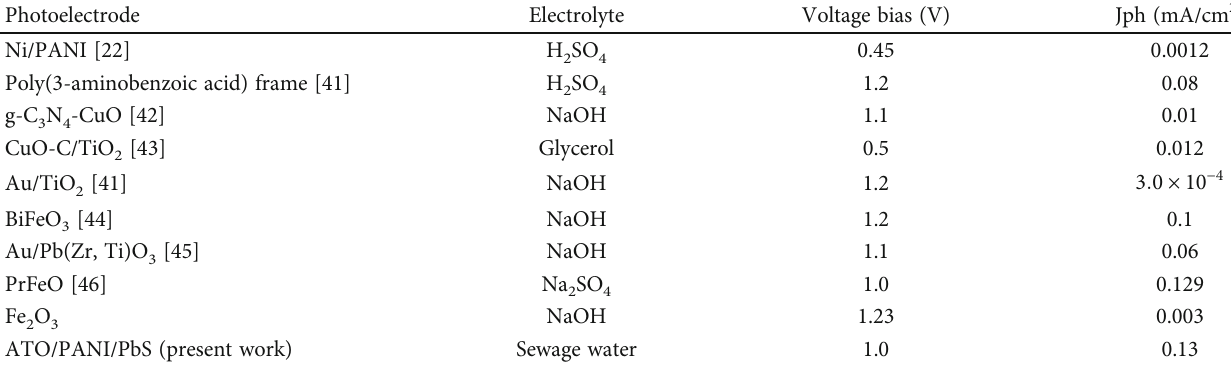
Figure 7: (a and b) The temperature e ff ect on ATO/PANI/PbS. The relations between (c) temperature reciprocal and LnJ temperature reciprocal and LnJ /T. ph Table 3: Comparison of the electrolytes and J